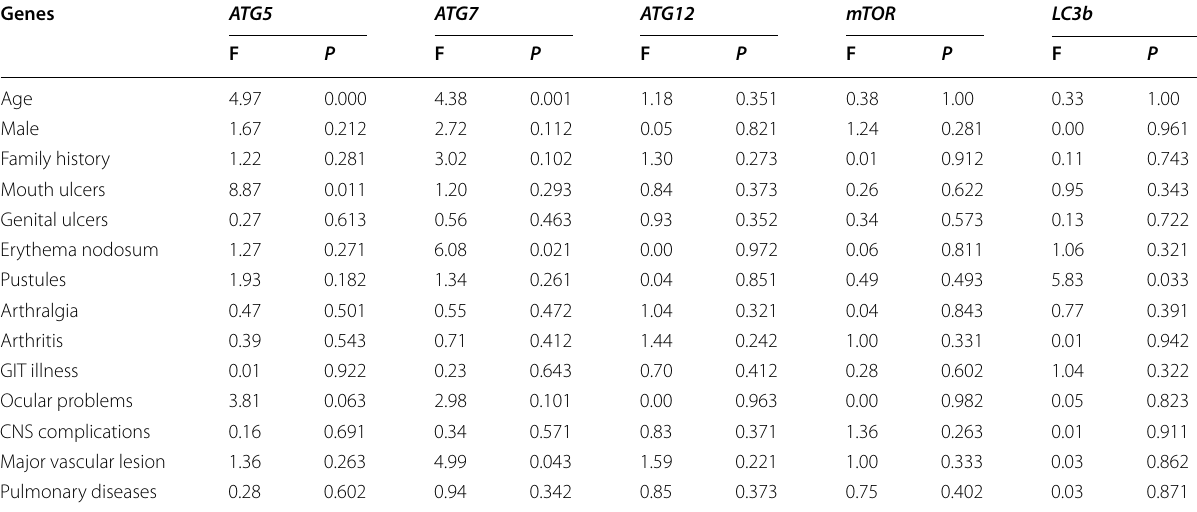
Table 4 Association of disease manifestation with relative mRNA expression of different studied autophagy genes